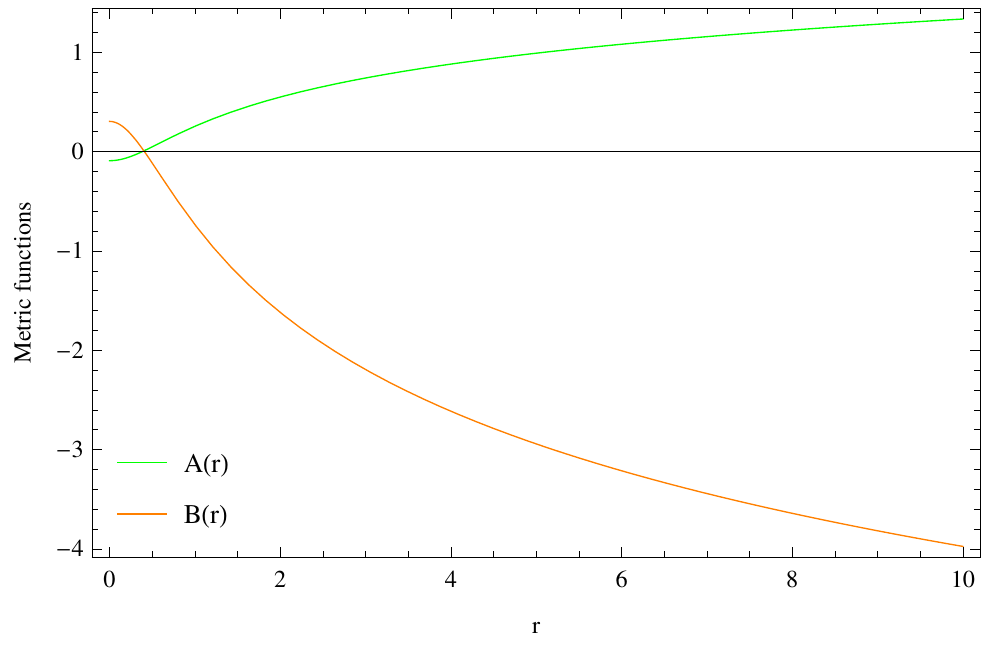
Figure 2. The metric functions for quintessence field, ω = − 1/3, are plotted against the radial parameter r , for the values of constants C 1 = 0.01, C 2 = 0.5. The pressure and density are deduced